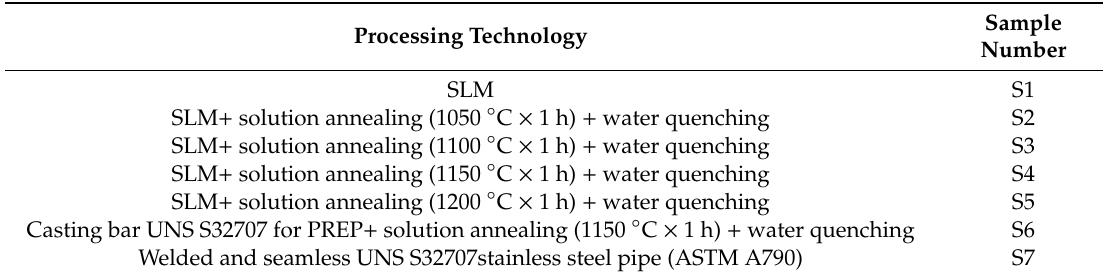
Table 2. The sample numbers of di ff erent processing technologies. Processing Technology